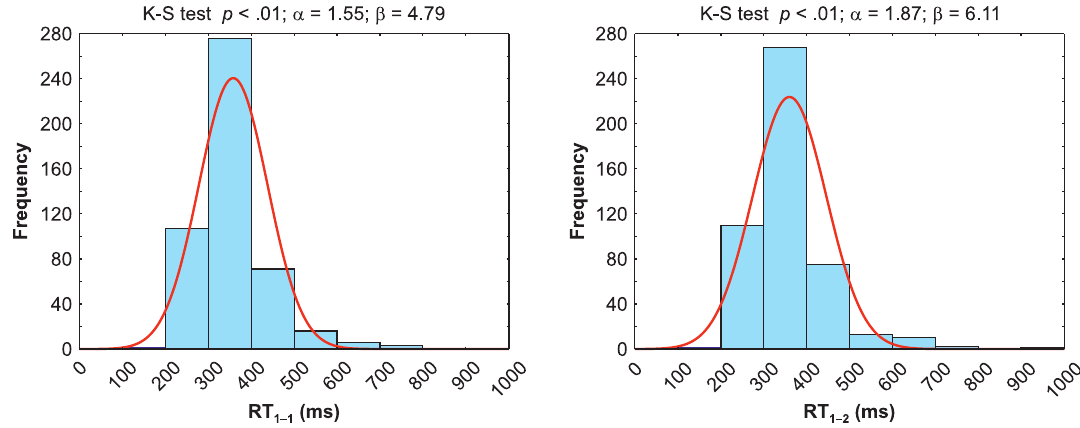
, RT = reaction times in 1–1 1–2